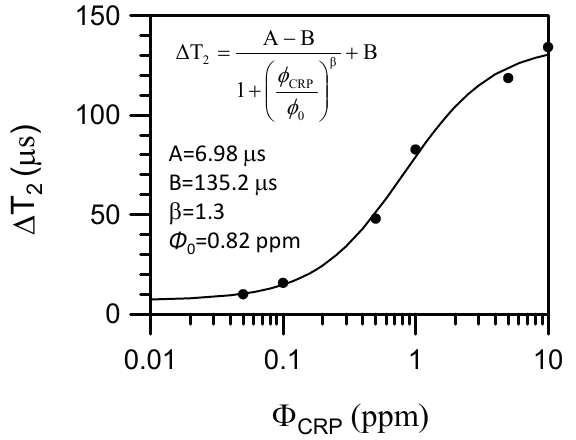
Figure 6. Δ T 2 of protons as a function of CRP